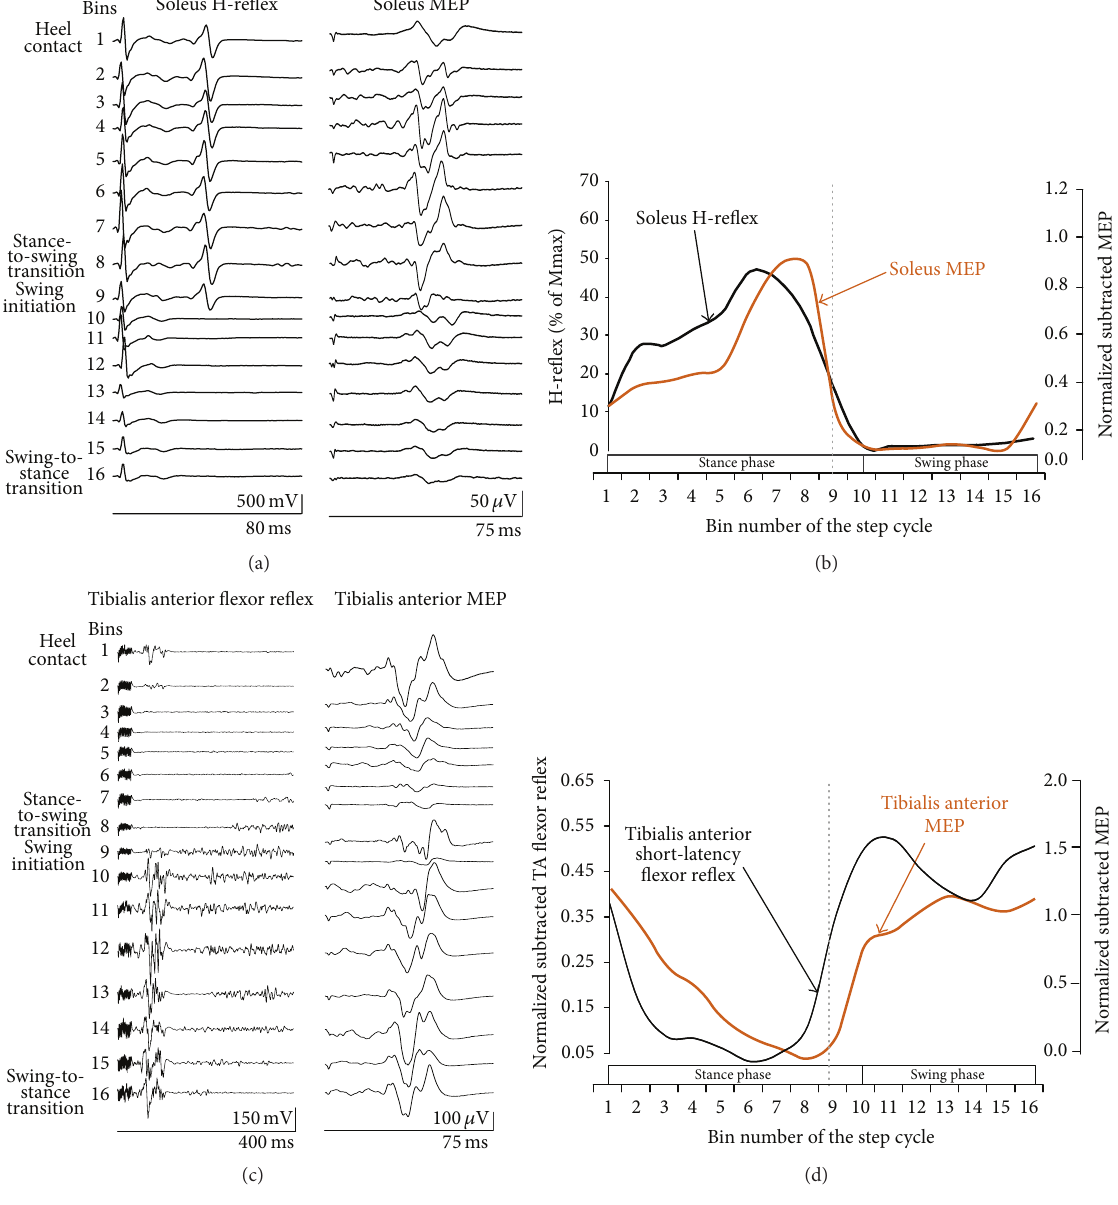
Figure 1: Modulation of neuronal activity while walking in uninjured humans. (a, b) Soleus H-reflexes and soleus motor evoked potentials (MEPs) amplitude at each bin of the step cycle while stepping on a motorized treadmill for single subjects (a) and for a group of healthy subjects (b). (c, d) Short-latency tibialis anterior (TA) flexor reflexes and TA MEPs amplitude at each bin of the step cycle while stepping on a motorized treadmill for single subjects (c) and for a group of healthy subjects (d). For the grouped data, for each bin of the step cycle, the soleus H-reflex was normalized to the maximal M-wave evoked 60–80 ms after the test H-reflex, and the short-latency TA flexor reflexes and soleus/TA MEPs were normalized to the maximum homonymous locomotor EMG having subtracted the control EMG (EMG without stimulation) at identical time windows and bins. Each step was divided into 16 equal bins based on the signal from the right foot switch. Bin 1 corresponds to heel contact. Bins 8, 9, and 16 correspond approximately to stance-to-swing transition, swing initiation, and swing-to-stance transition, respectively. Vertical dotted lines designate the stance-to-swing transition phase. Data adopted and modified from [2, 16, 21,